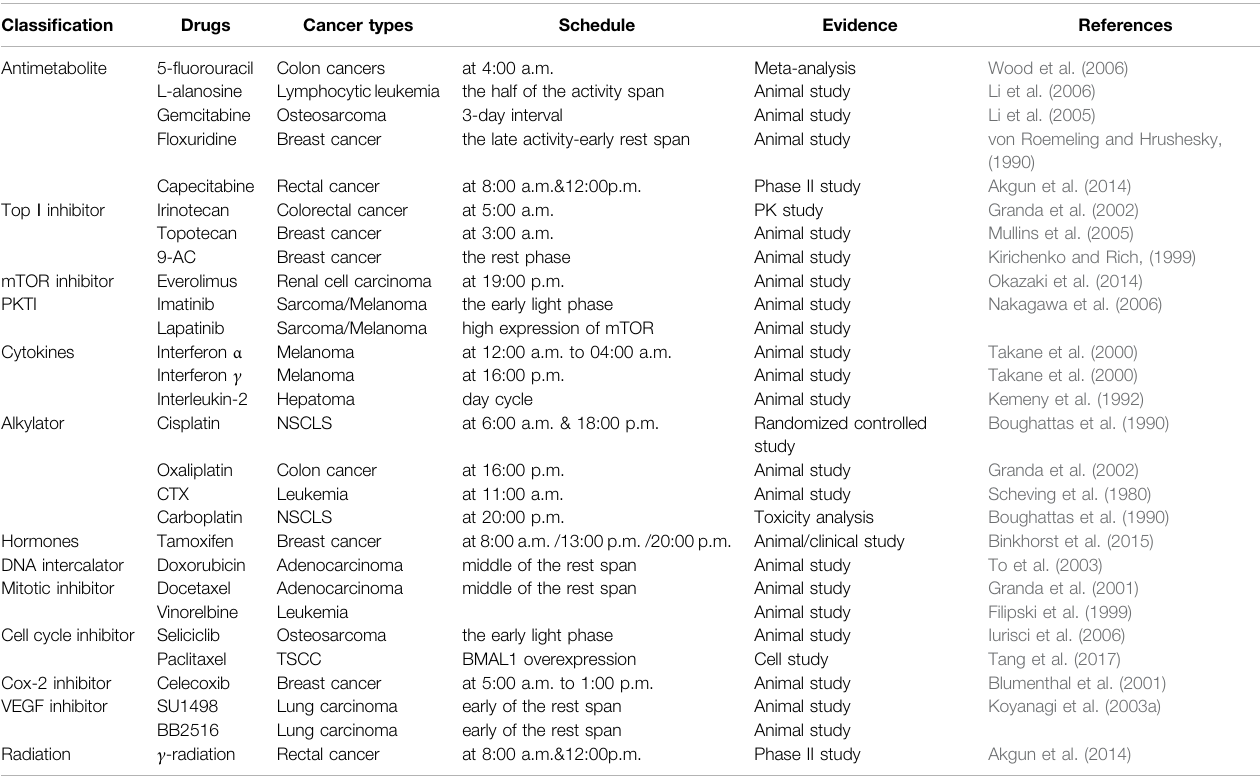
TABLE 2 | The correlation between anticancer drugs and circadian rhythmicity from studies. Classi fi